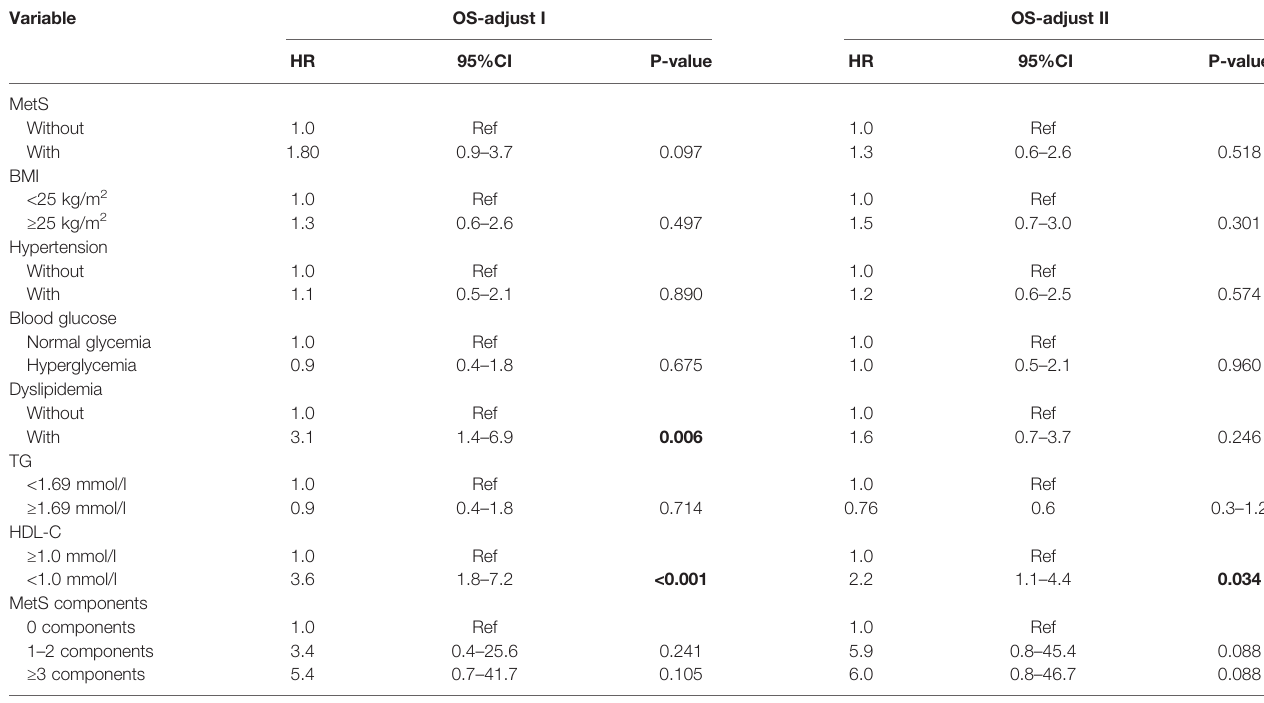
TABLE 4 | Cox multivariate analysis of OS for MetS and its components in EC